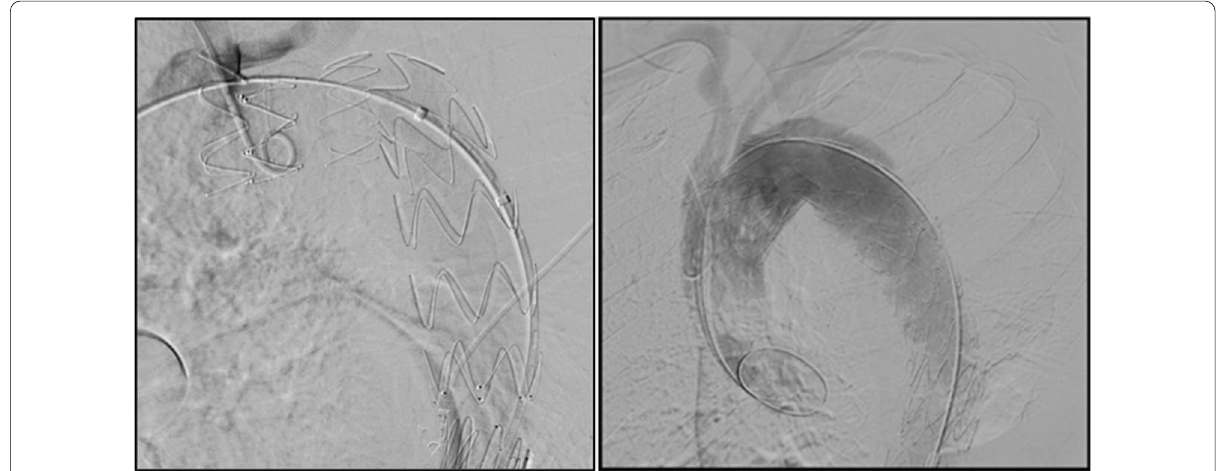
Fig. 1 The left subclavian artery was covered during deployment of a thoracic endograft